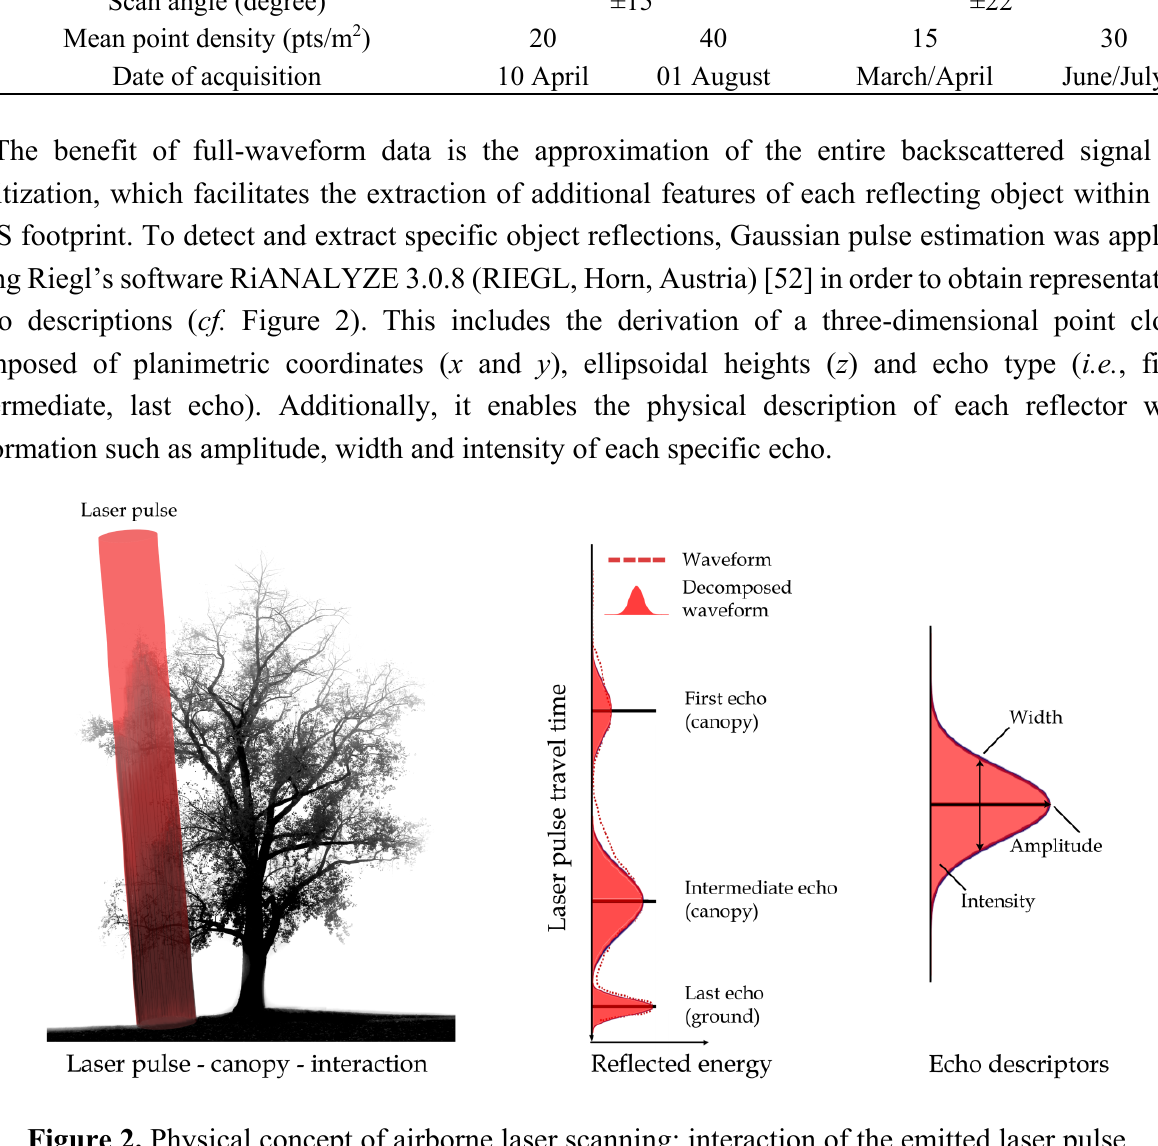
Figure 2. Physical concept of airborne laser scanning: interaction of the emitted laser pulse with the vegetation canopy (left panel), the full and the decomposed waveform (middle panel), and the resulting echo